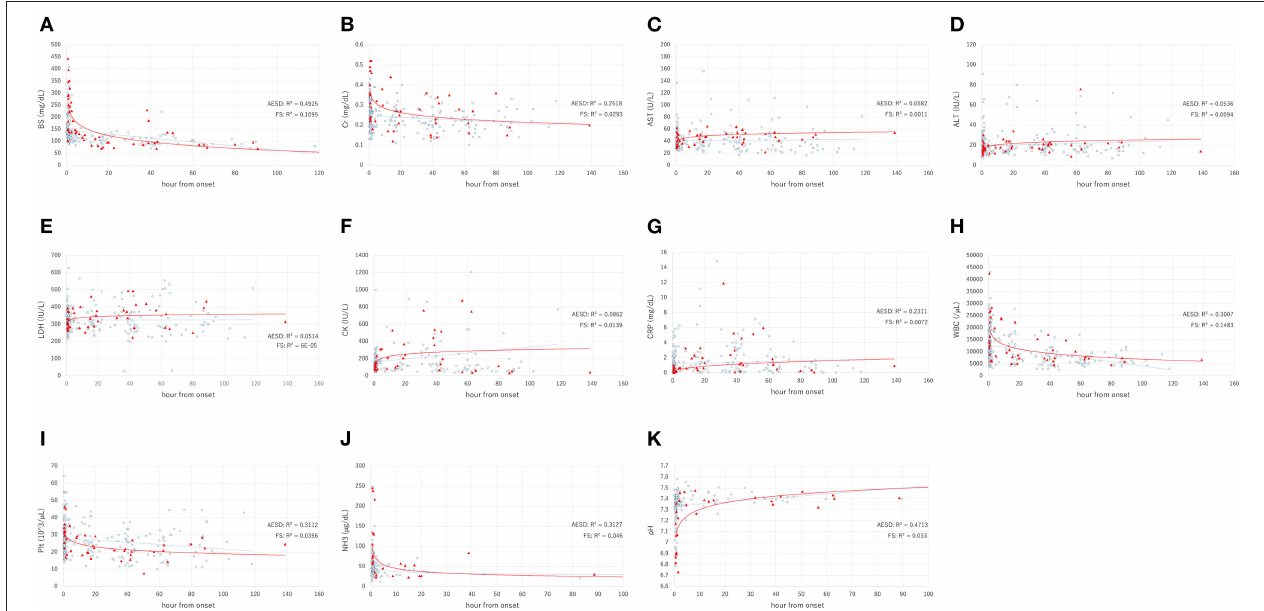
FIGURE 1 | The laboratory data values, including the levels of blood sugar (BS) (A) , serum creatinine (Cr) (B) , aspartate aminotransferase (AST) (C) , alanine aminotransferase (ALT) (D) , lactate dehydrogenase (LDH) (E) , creatine kinase (CK) (F) , C-reactive protein (CRP) (G) , white blood cell (WBC) count (H) , platelet count (Plt) (I) , ammonia (NH3) level (J) , and pH (K) , in acute encephalopathy with biphasic seizures and late reduced diffusion (AESD) (filled triangles), and febrile seizure (FS) (open circles). The X and Y axes show the hours from onset and the value, respectively. The solid line and dotted line indicate the fitted curves for AESD and FS,